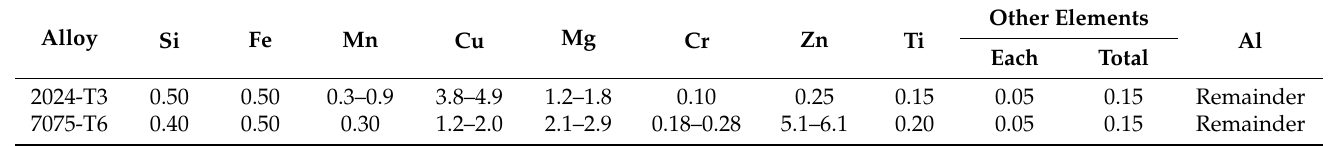
Table 1. Chemical composition of test sheets in wt.% [36].